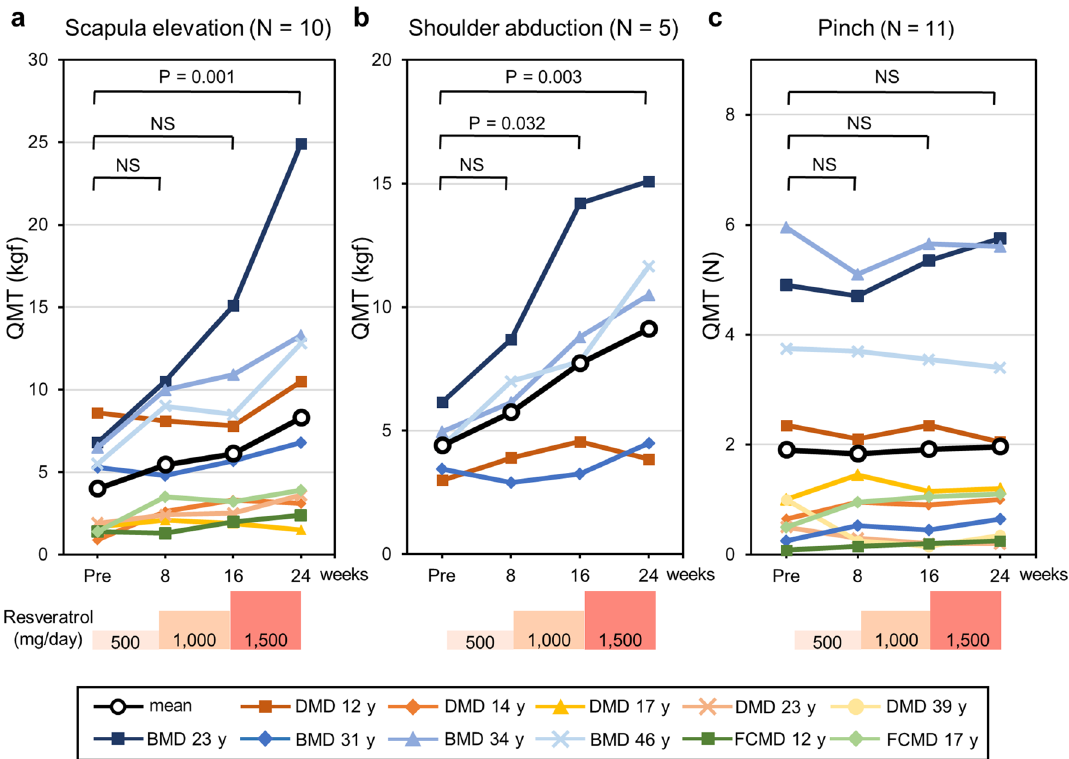
Figure 3. Muscle strength following resveratrol administration. ( a – c ) Time course of muscle strength for ( a ) scapula elevation (N = 10), ( b ) shoulder abduction (N = 5), and ( c ) pinch (N = 11) measured by quantitative muscle testing (QMT) using a hand-held dynamometer and pinch strength metre before (Pre) and 8, 16, and 24 weeks after resveratrol administration. The daily dose of each patient is also shown, except that one patient with FCMD (FCMD 12 y) received 1000 instead of 1500 mg/day. Black lines show mean values. Average values at each visit were compared with those before medication and were analysed using ANOVA. Post hoc analysis was performed using Dunnett’s test. P values < 0.05 are indicated. NS: not